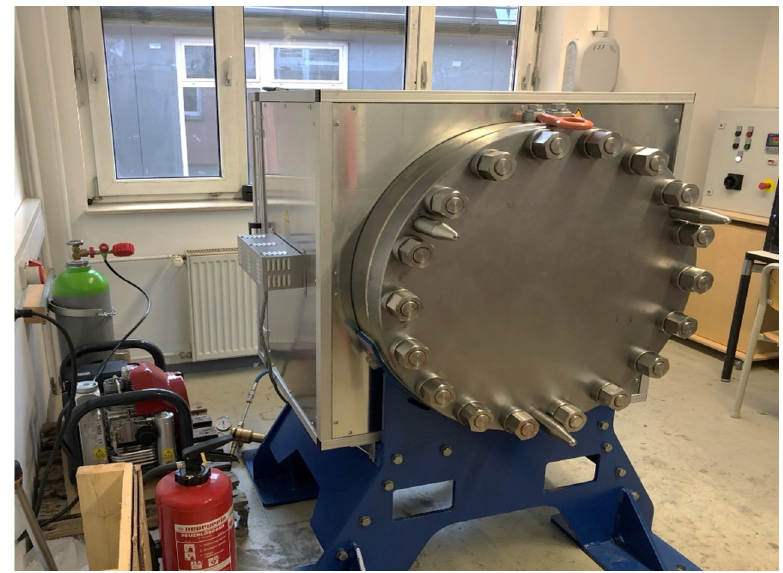
Figure 3. Autoclave setup in the laboratory.